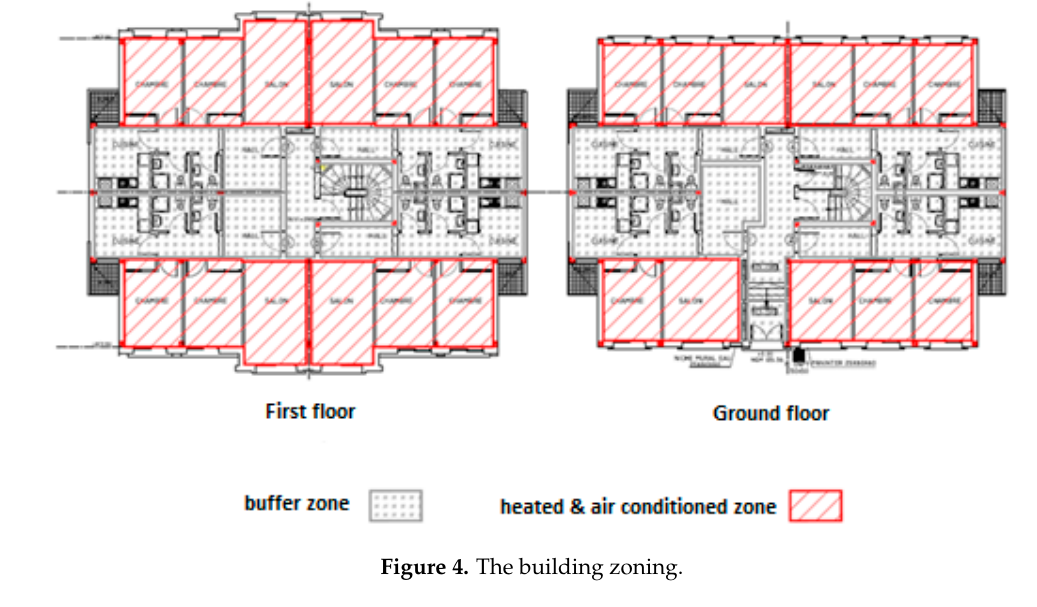
Figure 4. The building zoning.